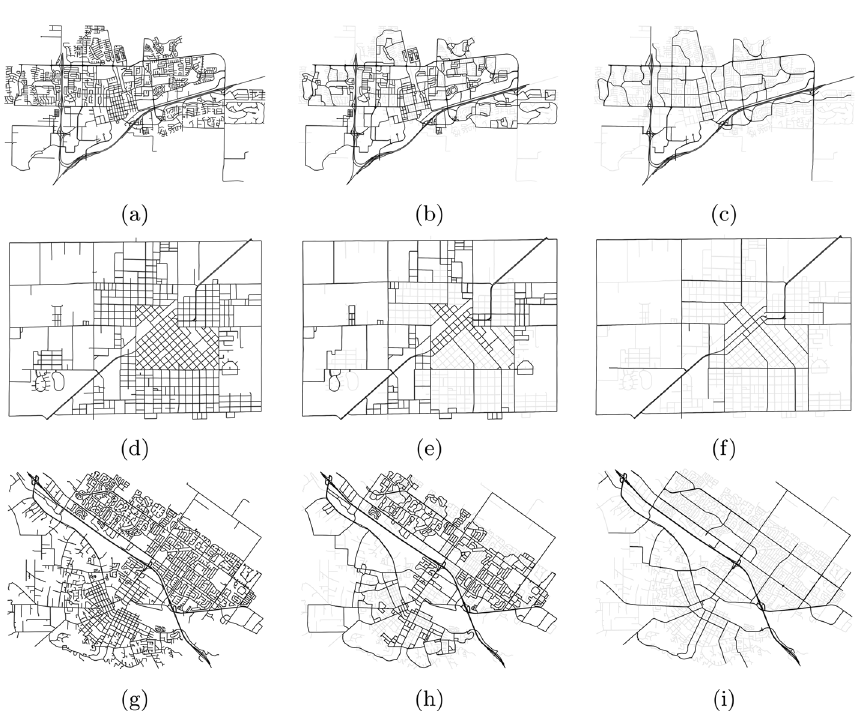
Fig. 3 Visualization of original and simplified road networks. Left column ( a , d , g ): input network, middle column ( b , e , h ): simplified by the proposed method, right column ( c , f , i ): simplified by omitting all residential road. Top row ( a , b , c ): Davis, middle row ( d , e , f ): Portales, bottom row ( g , h , i ):